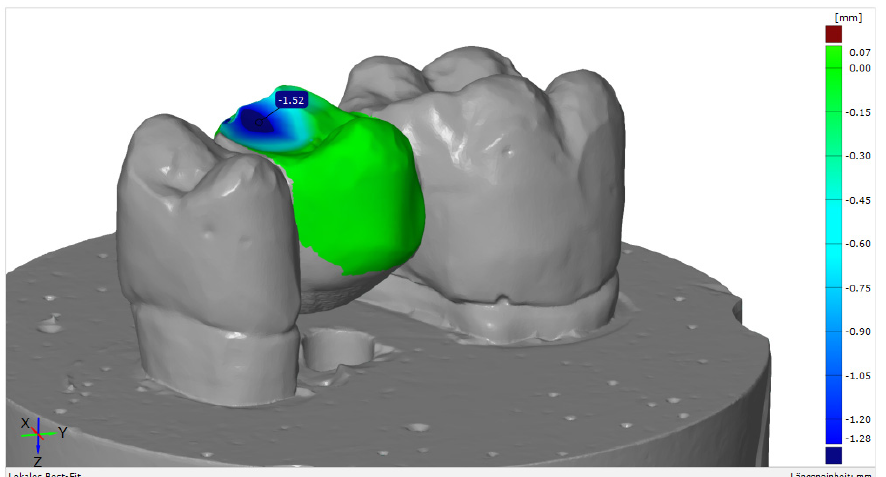
Figure 3. Example of a surface match analysis with GOM Inspect software, v. 2020 (GOM GmbH, Braunschweig, Germany).